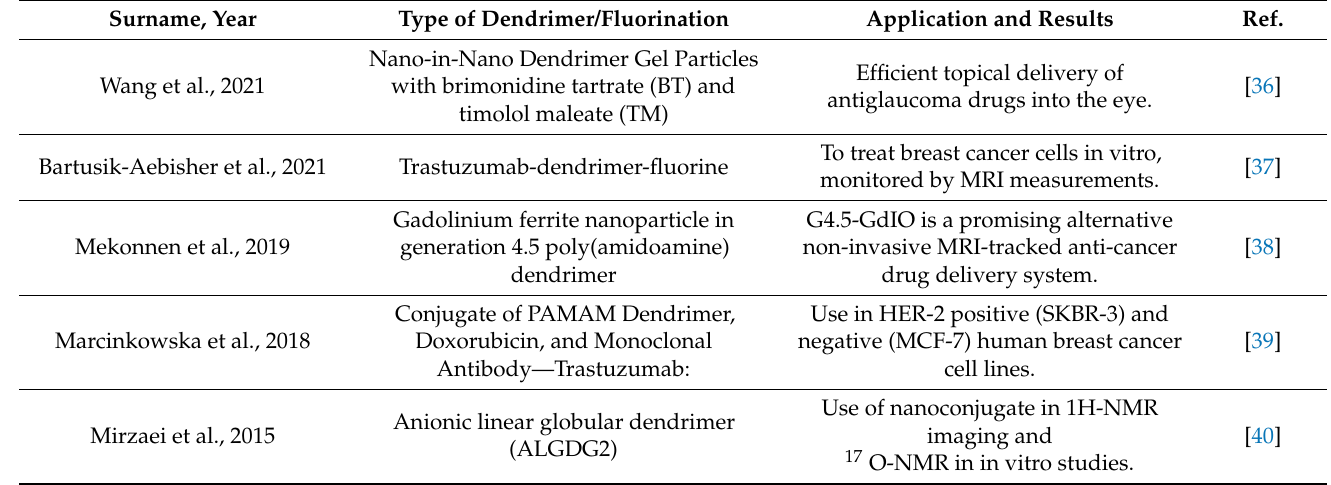
Table 1. Use of various dendrimer conjugates with pharmaceutically active